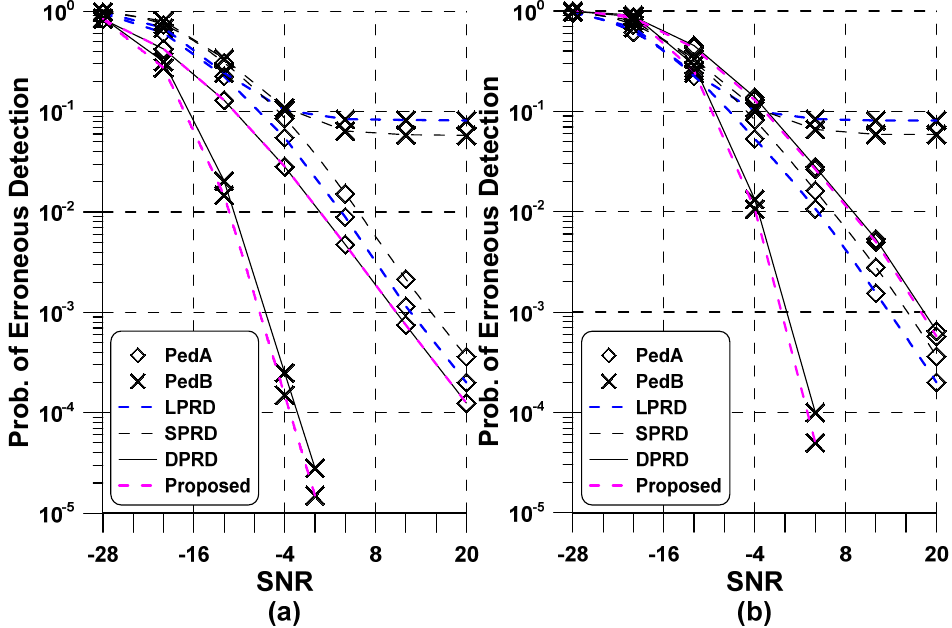
Figure 2. Performance comparison of the benchmark and proposed methods in the pedestrian channel models: ( a ) perfect channel ( b ) estimated